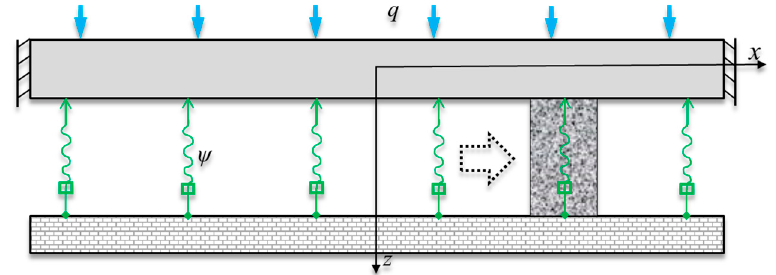
Figure 10. Mechanical model of filling–roof plate system.